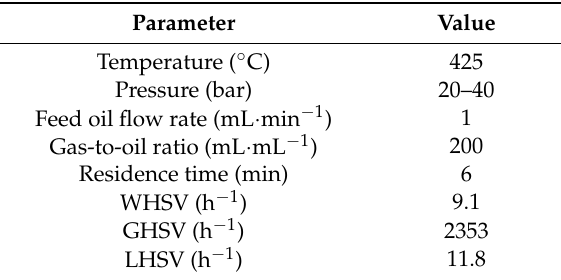
Table 1. Experimental